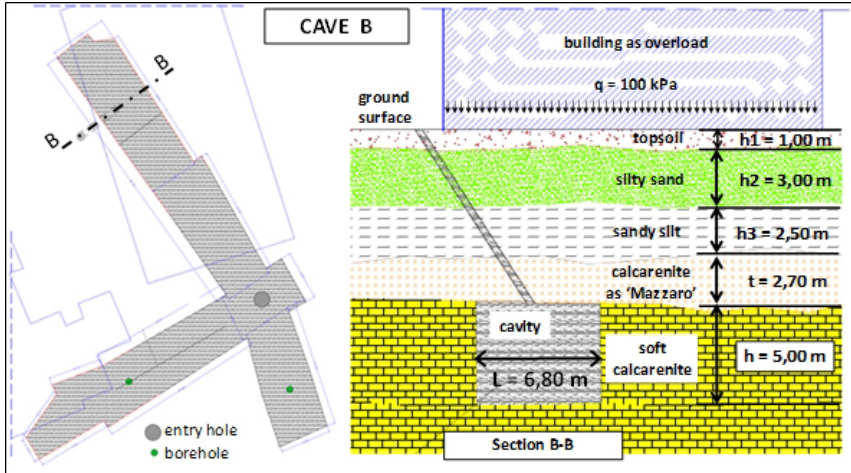
Figure 21. Plan and stratigraphy of the underground cavity B (adapted from Maglio and Ligori,